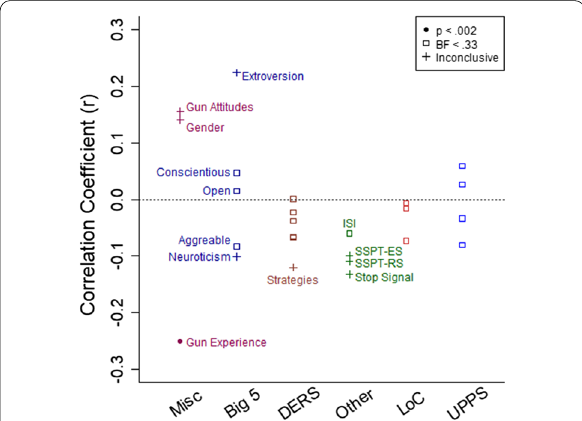
Fig. 9 The correlation coefficient for each comparison with the gun embodiment effect measured with reaction time. The coefficients are plotted as a function of category of comparison and whether the p value met the criteria for statistical significance after Bonferroni correction ( p < .002, filled circles), substantial evidence for the null over the alternative hypothesis (BF < .33, open squares), or inconclusive